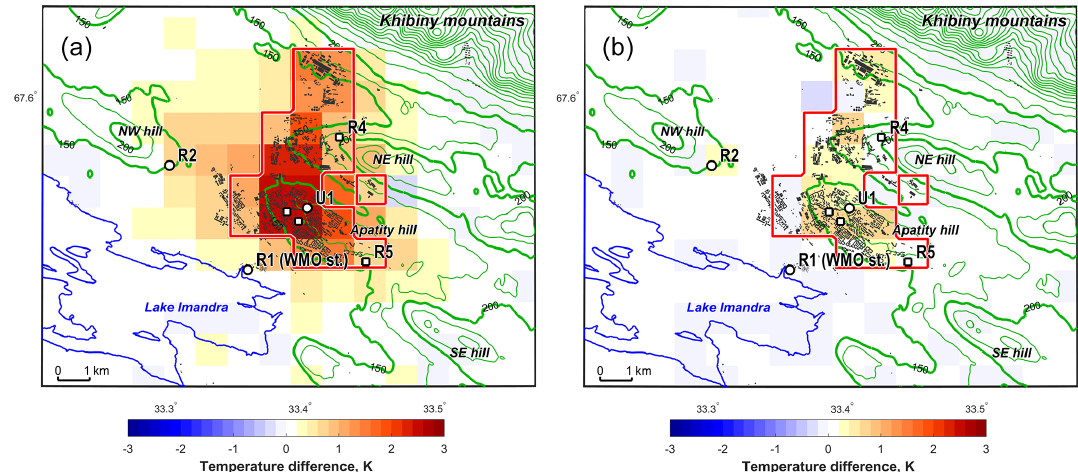
Figure 9. Maps of the simulated surface air temperature difference between the COSMO-CLM runs: URB_AHF – noURB (a) and URB_noAHF – noURB (b) . The differences are averaged over the six selected periods identified in Fig. 7. Similar differences averaged over the whole winter are shown in the Fig. S9. The urban land use/land cover was introduced in the grid cells encompassed by the red